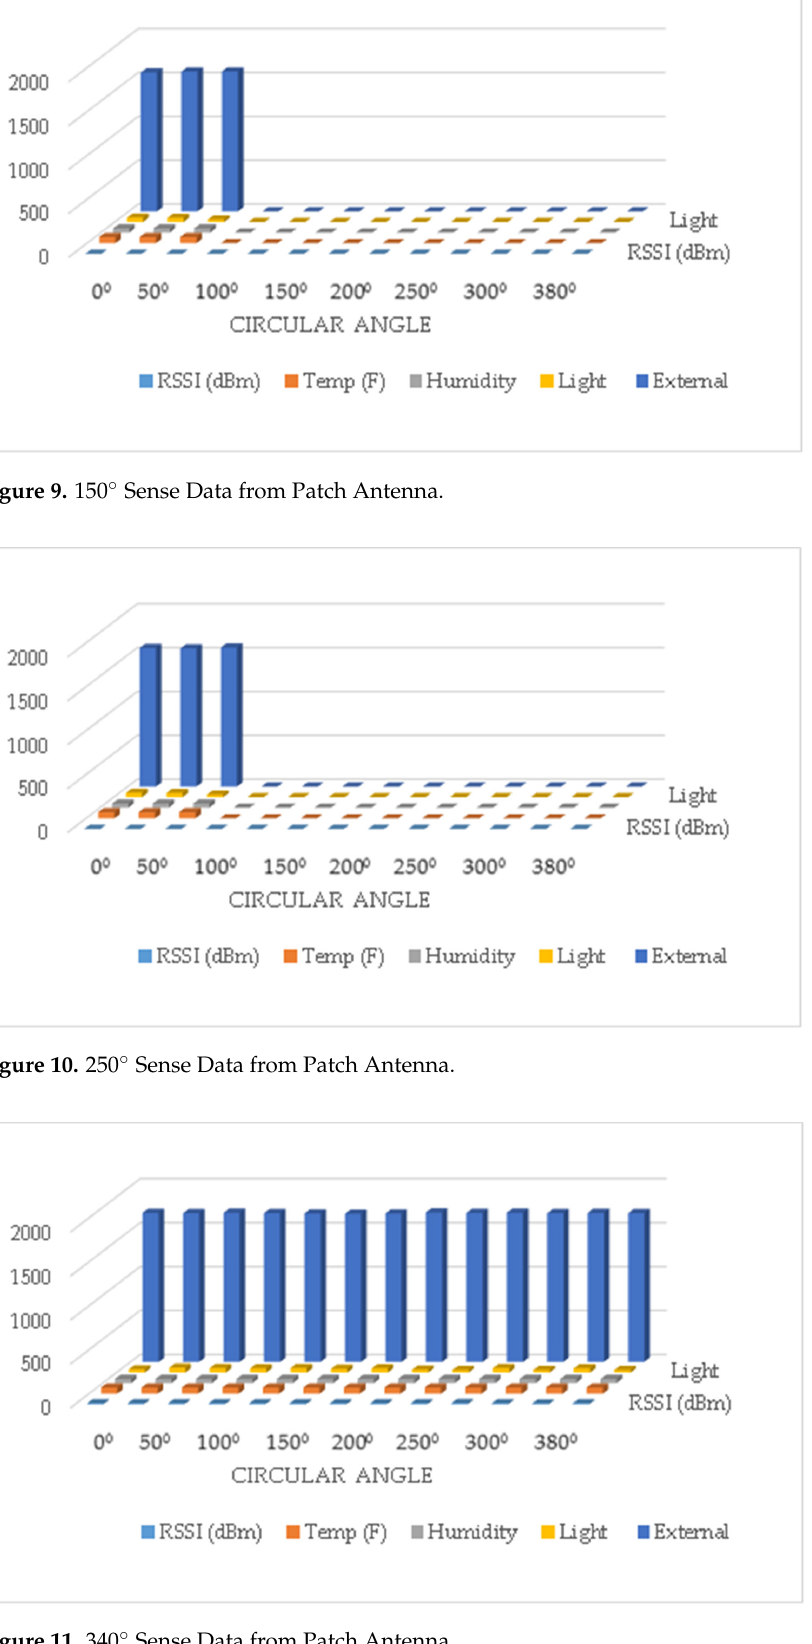
Figure 12. Sensor Device Placement for Dipole Antenna. Table 1. Patch Antenna Sensed Data. Point 1 (0°) RSSI